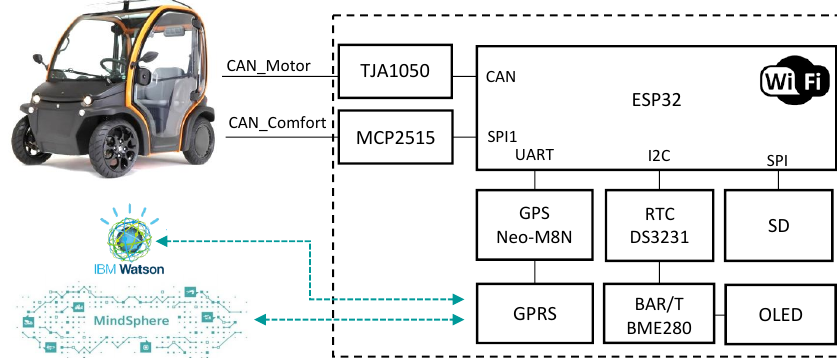
Figure 2. Block diagram of the